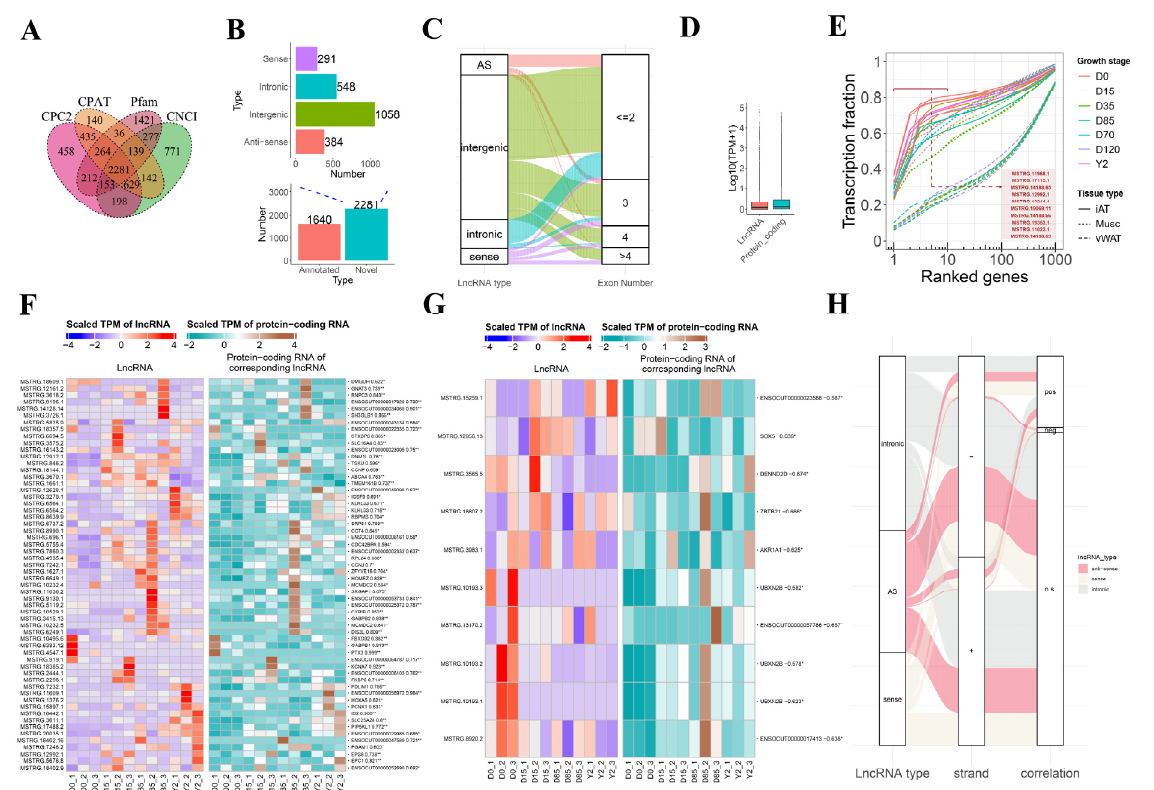
Figure 2. Genome-wide identification and characterization of lncRNAs during ARBW of rabbit iATs. ( A ) The Venn diagram of lncRNA transcripts from four types of software, including CPC2, CPAT, CNCI and Pfam. Only the lncRNAs identified by all the four types of software were used for downstream analyses. ( B ) Classification of novel lncRNAs and integration of novel lncRNAs and Esembl annotated lncRNAs expressed in the iATs. The upper panel indicates the classification of novel lncRNAs and the bottom panel shows total numbers of expressed Ensembl annotated lncRNAs and novel identified lncRNAs. ( C ) Alluvial diagram analysis of exon number of expressed lncRNAs shows that a higher proportion of SO lncRNA (purple stream) contains multiple exons. ( D ) Box plots of expression levels for lncRNA and protein-coding genes in rabbit iATs. ( E ) Comparison of transcriptional complexities among iATs, vWATs and skeletal muscle tissues. Every curve shows that the cumulated distribution of the fraction of total transcription contributed by lncRNAs when sorted from most to least expressed ones in each tissue. The different curve colors indicate different growth stages and different curve types indicate different tissue types of rabbits. iATs, interscapular adipose tissues. Musc, skeletal muscle tissues. vWAT, visceral white adipose tissues. The top 10 expressed lncRNAs of iAT in D0 are listed in the figure. ( F , G ) Heatmap analysis of AS lncRNAs and their anti-sense protein-coding genes. The left heatmap depicts the lncRNA expression pattern and the right heatmap depicts the anti-sense protein-coding gene expression patterns across samples. The Pearson’s correlation coefficients and P values of significance tests were marked following protein-coding gene symbols. The “*” represents p < 0.05 and “**” represents p < 0.01. ( H ) AS lncRNA that were negatively correlated with their corresponding protein-coding genes were prone to enrich in the negative strand of genome. The “pos” represents “a positive correlation with protein-coding genes” and “neg” represents “expression of lncRNAs negatively correlated with protein-coding genes” and n.s. represents “a negative correlation with protein-coding genes”. Most of the lncRNAs in “neg” came from AS lncRNAs that transcribed from negative strand (red stream).